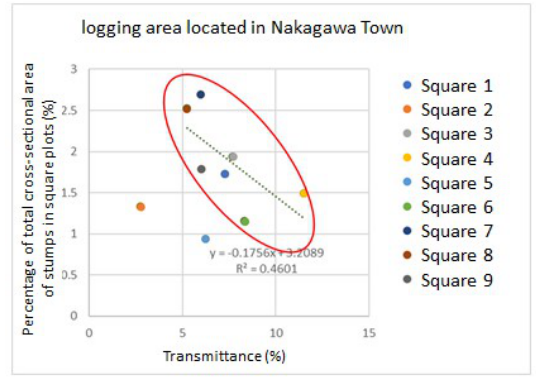
Figure 20 . Relationship between LiDAR transmittance and total cross-sectional area in Yamizo sedimentary rock